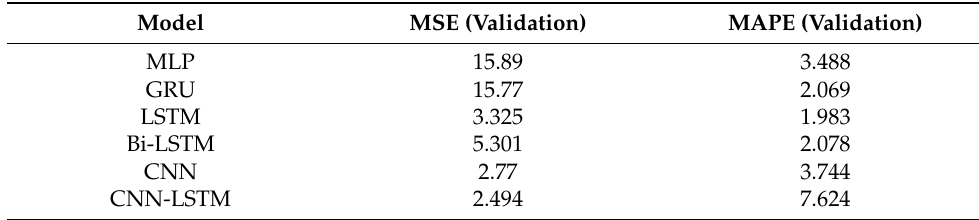
Table 11. The validation results of the models using Apple data with six input features.